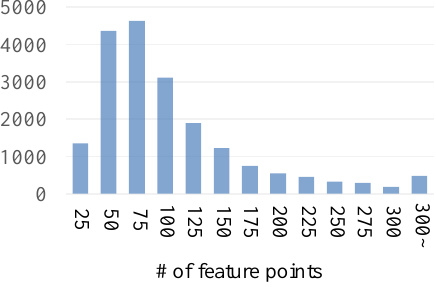
Figure 7. Distribution of number of feature points